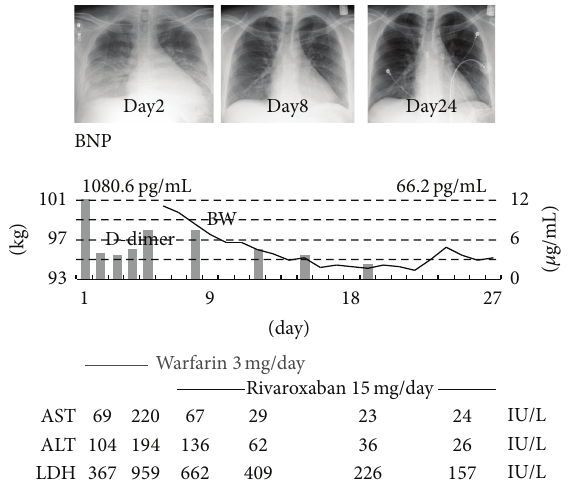
Figure 4: Clinical course. This figure demonstrates the course of acute heart failure and the changes of value of D-dimer and hepatic aminotransferase. Though hepatic function worsened by the fifth day, it improved gradually after switching anticoagulants.